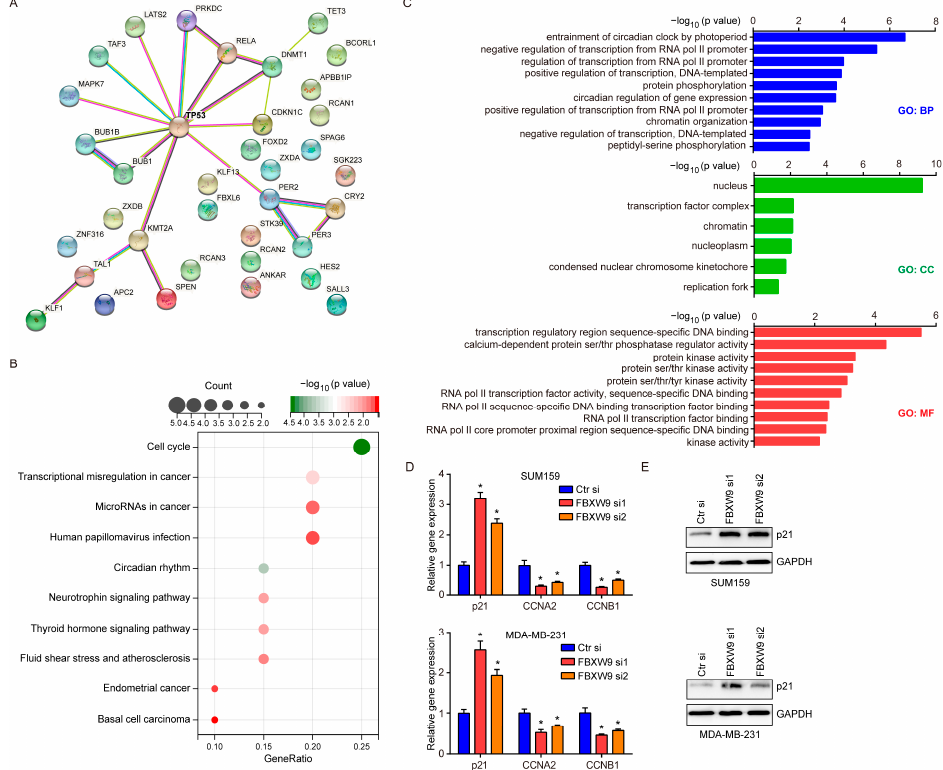
Figure 6. Analysis of potential targets of FBXW9. ( A ) The potential substrates of FBXW9 were predicted using Ubibrowser, and the interaction between these proteins was analyzed using the STRING database. ( B ) KEGG analysis of potential targets of FBXW9 substrates. ( C ) GO analysis of potential targets of FBXW9 substrates. ( D ) qPCR detection of mRNA expression of p21, CCNA2, and CCNB1 in breast cancer cells transfected with Ctr si, FBXW9 si1, or FBXW9 si2. ( E ) Western blotting detection of p21 protein expression in breast cancer cells transfected with Ctr si, FBXW9 si1, or FBXW9 si2. *, p < 0.05.